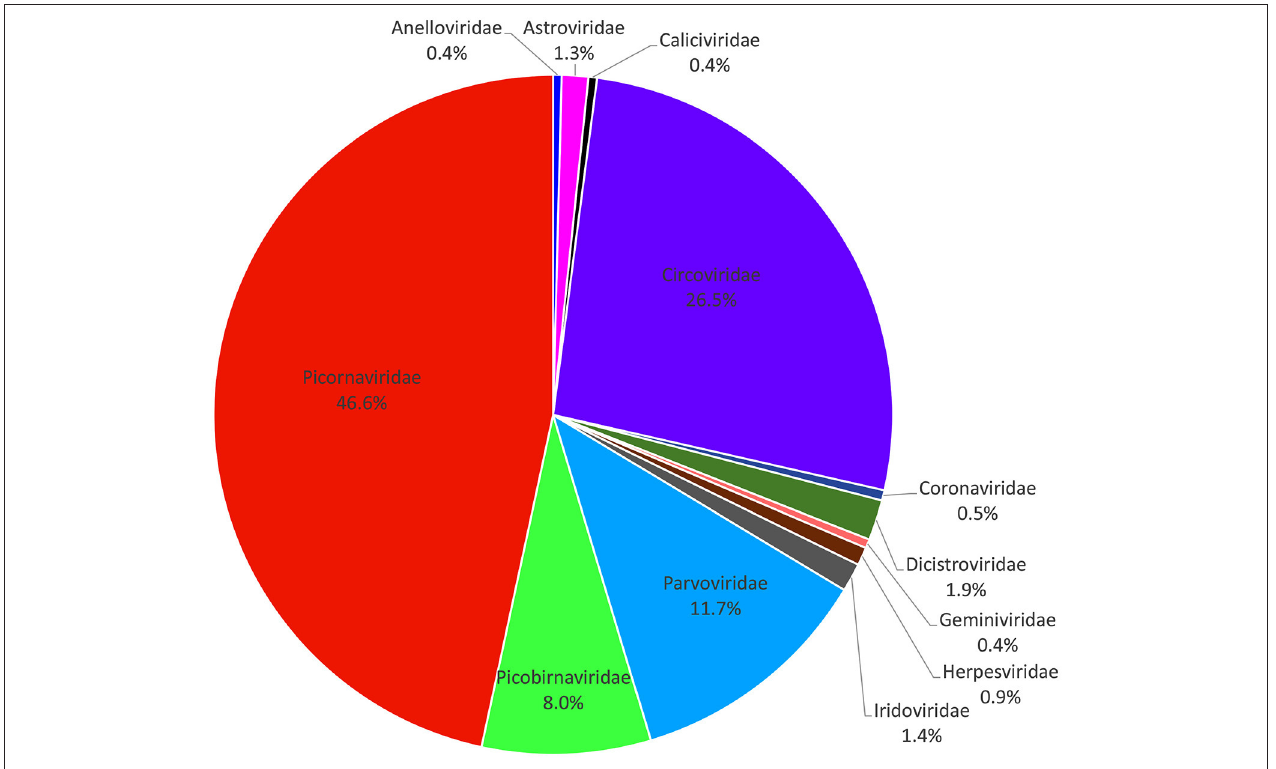
FIGURE 1 | Composition of fecal virome detected in raccoon dogs. The percentage of virus sequences in different virus families was